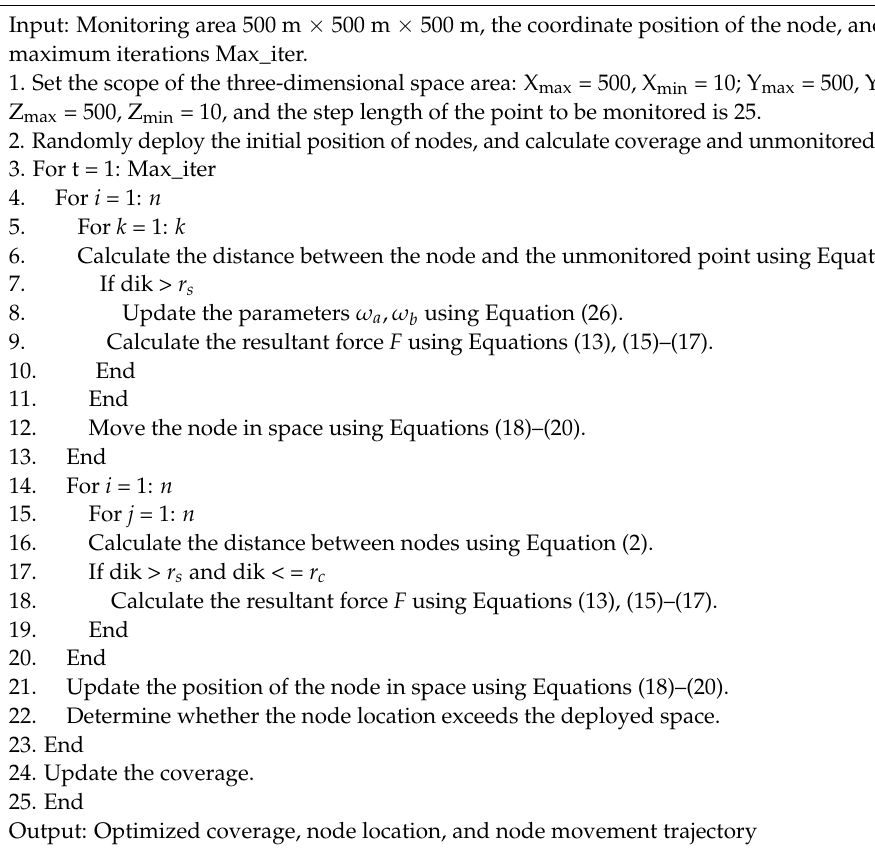
Algorithm 1: Pseudo-code of the 3D-IVFC